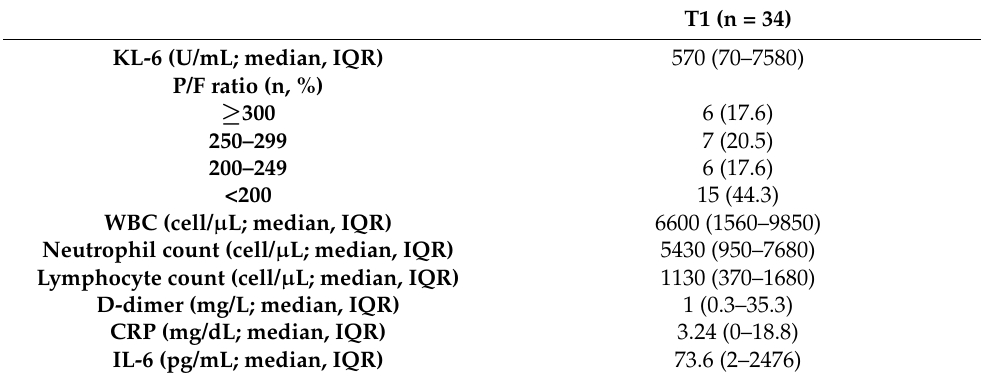
Table 2. Clinical and laboratory characteristics of the enrolled patients at the time of 7 days from enrolment—T1 (n = 34).